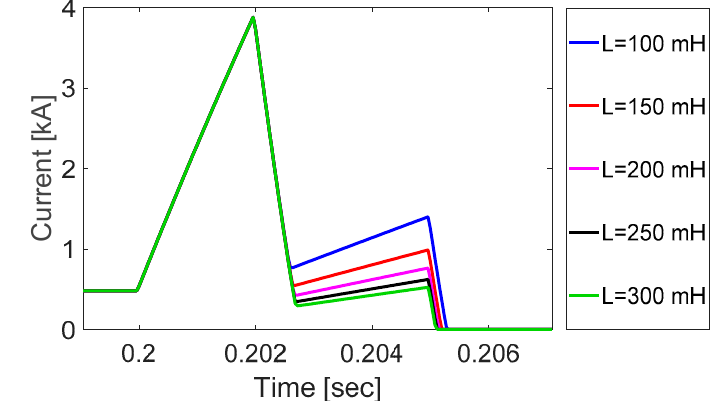
Figure 14. The influene of L on overall DC current.